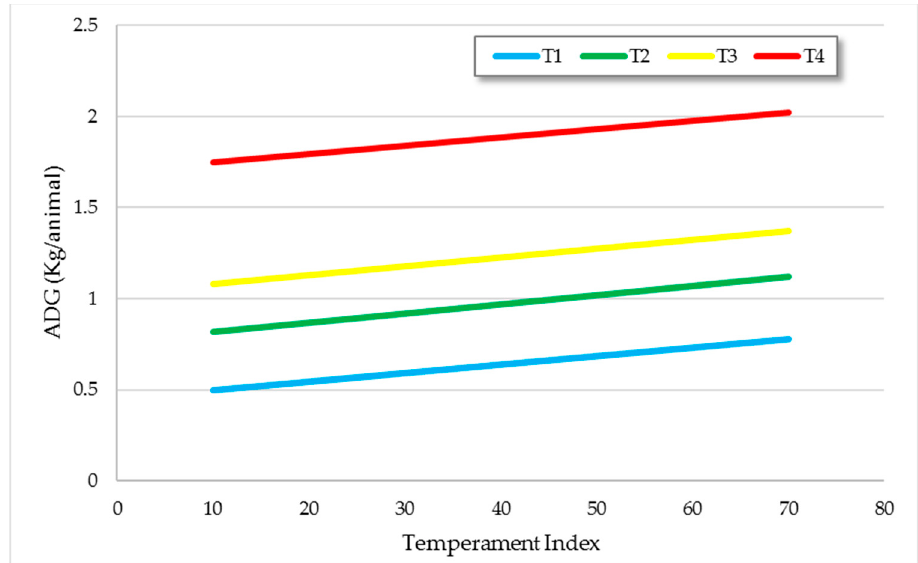
Figure 1. Average daily gains according to multicriterial temperament index (TIndex). Trendlines per treatment, estimated by regression analysis ( R 2 = 0.85).